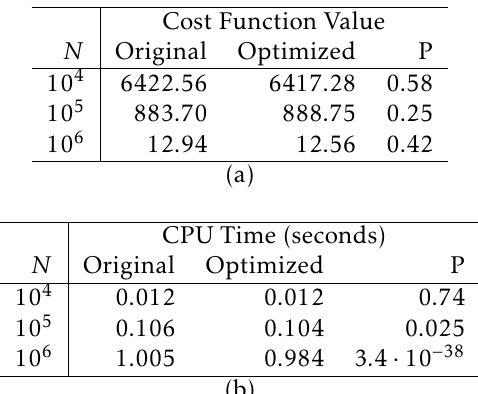
Table 2. BoundMax: (a) optimization cost function, and (b) CPU time. Results are averages of 100 runs, and the P column shows t-test